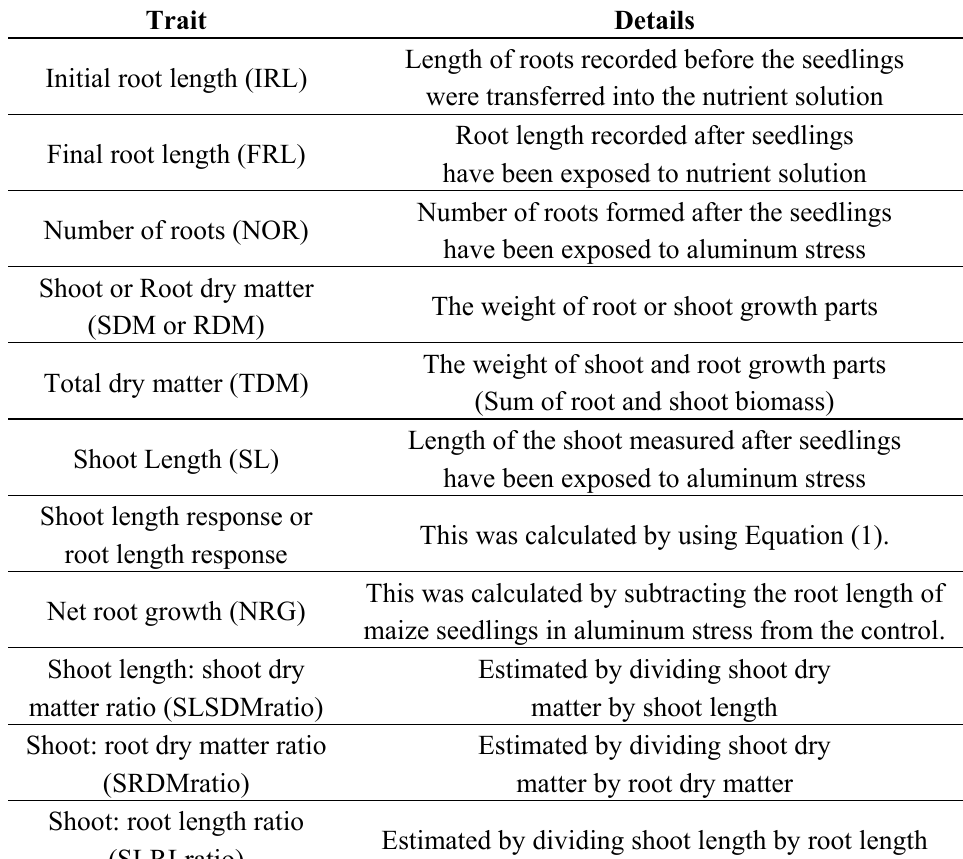
Table 1. Maize root seedling characteristics measured in the study.